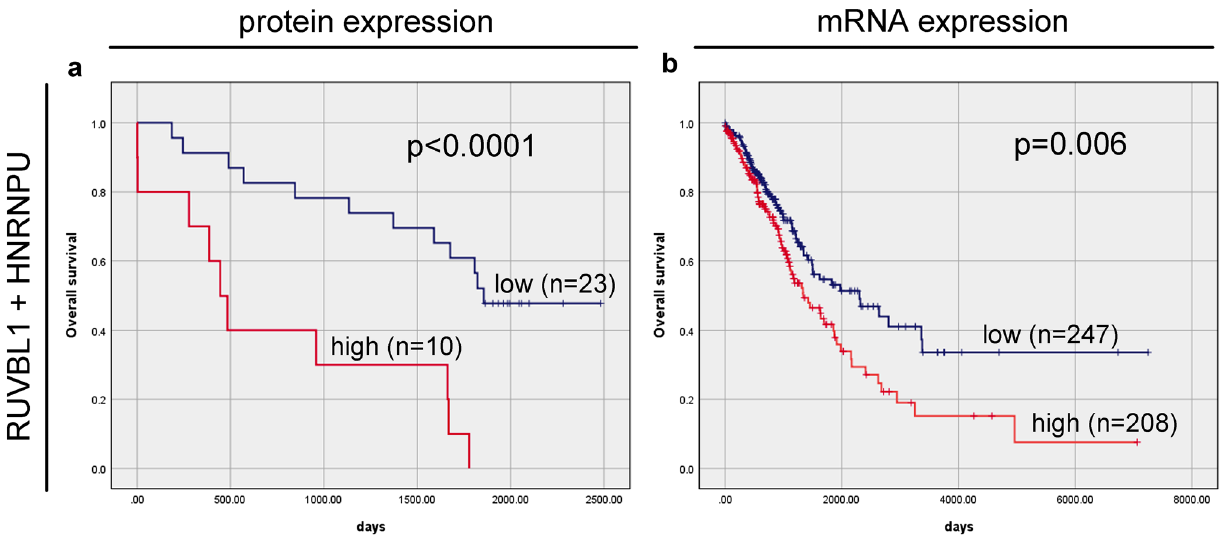
Fig. 4 Overall survival analysis according to the combination of A RUVBL1 and HNRNPU proteins and B RUVBL1 and HNRNPU mRNAs. R + H + simultaneous high expression of RUVBL1 and HNRNPU proteins; R − H − simultaneous low expression of RUVBL1 and HNRNPU proteins; R + H + simultaneous high expression of RUVBL1 and HNRNPU mRNAs; R − H − simultaneous low expression of RUVBL1 and HNRNPU mRNAs, n number of patients in the group